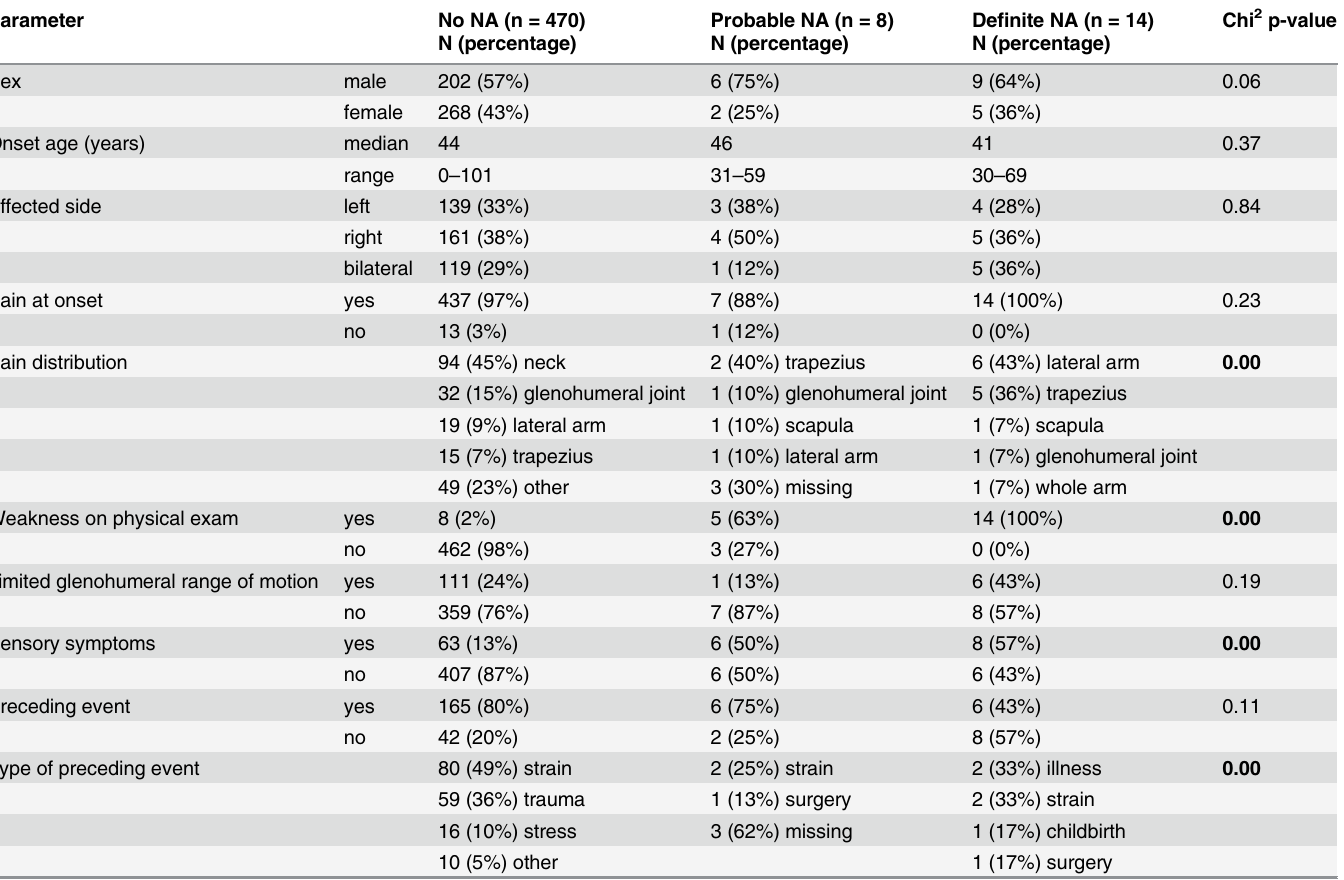
Table 3. Demographics and symptoms distribution between patient